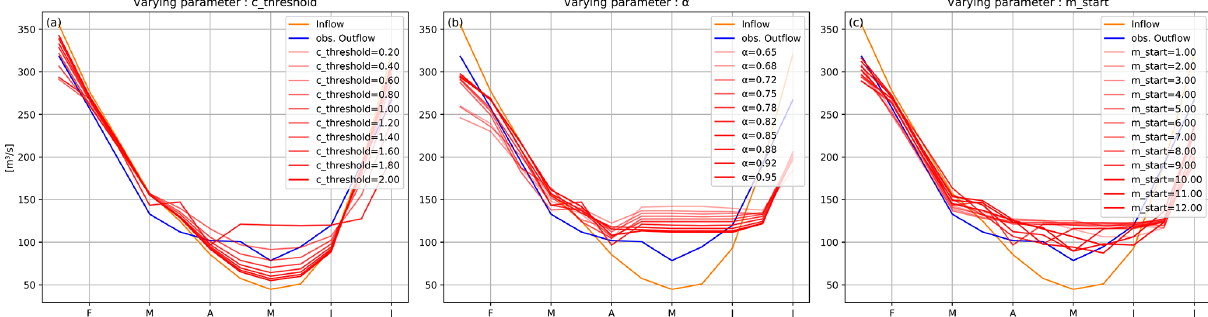
Figure 8. An example of the seasonal pattern sensitivity of the Alcantara II hydroelectricity reservoir outflow to three of the DROP model parameters: (a) c threshold , (b) α and (c) m start . The remaining parameters were set at default values (see Table 2).